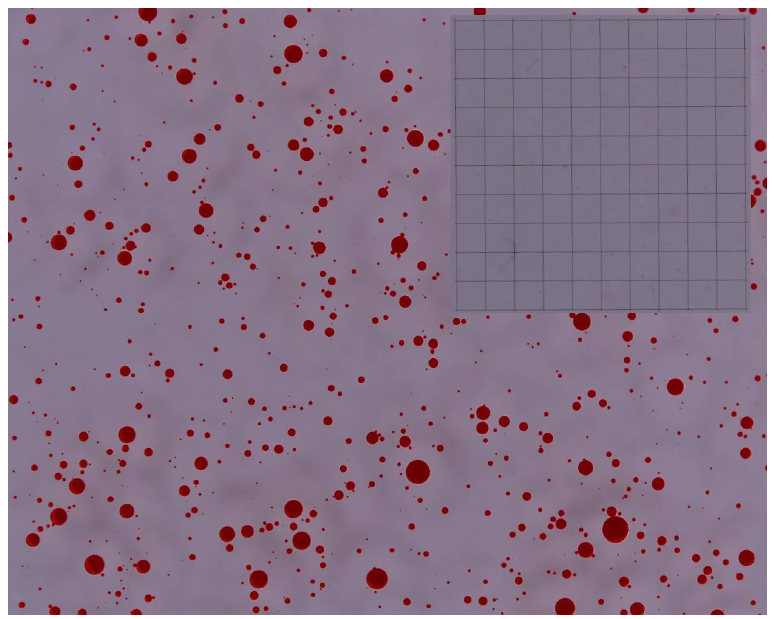
Figure 2. Example of image with the droplets captured by the silicone oil with superimposed the grid pattern for spatial calibration.